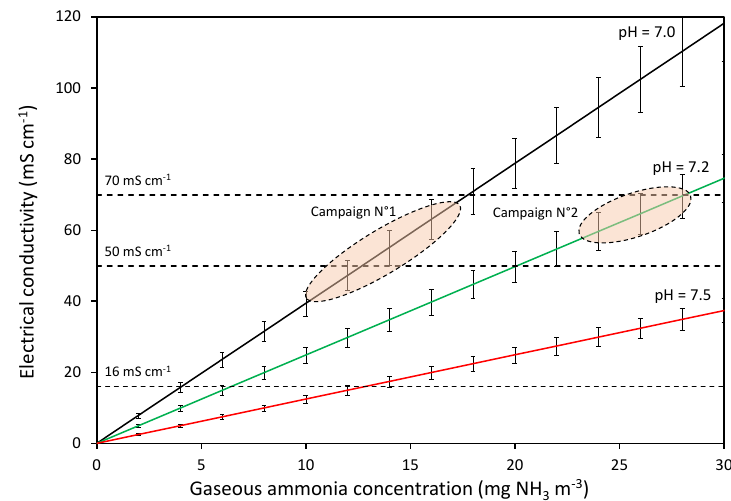
Figure 5. Lines: calculated values (Equation (11)) for the electrical conductivity of water where the ammonia driving force between phases becomes nil (i.e., equilibrium between ammonia concentration in the gas phase and free ammonia concentration in the liquid phase). pKa = 9.53 at 22 °C [17]; Henry coefficient H = 5.89 10 −4 at 22 °C [21]. Error bars indicate the influence of the change in temperature of the scrubbing liquid (±1 °C) on pKa and H calculation. Ellipses: maximum possible EC values for the experiment conditions recorded for phase 3 of campaign #1 (pH 7.0 and 𝐶 𝑁𝐻3𝑖𝑛 10 – 17 mg NH3 m − 3 ) and campaign #2 (pH 7.2 and 𝐶 𝑁𝐻3𝑖𝑛 24 – 27 mg NH3 m −3 ).